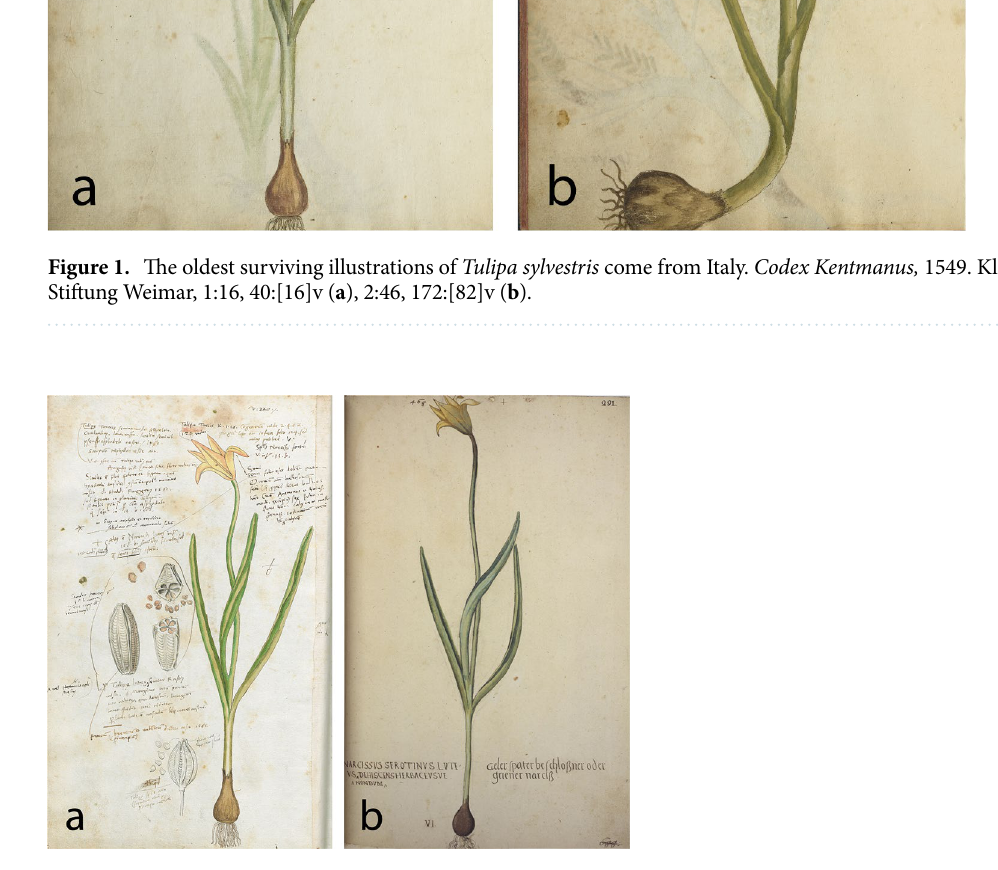
Figure 2. Kentmann’s illustration of Tulipa sylvestris was influential in sixteenth-century botany. Conrad Gessner kept a copy for his Historia Plantarum and drew on it the seeds he received from Melchior Wieland. University of Tartu, call nr: Mscr 55, f. 3v ( a ). An early watercolor found in the collection of Leonhart Fuchs, also presents remarkable similarity to Kentmann’s illustration. It is suggested to have been made by